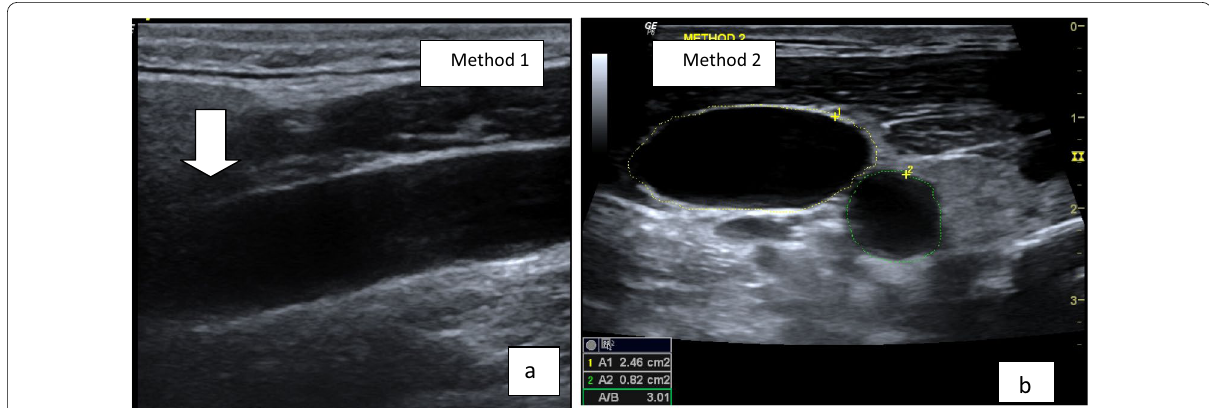
Fig. 6 Ultrasound images for a 40 years old female patient ( a ) a longitudinal ultrasound image where the IJV was distended although its neck course and no collapsing point was detected till the level of the skull base (vertical white arrow) (method 1) ( b ) transverse ultrasound image for the cross‑sectional areas (marked as dotted yellow lines by manual tracers) of the IJV ( (method 2). The Invasive CVP measurement (by the catheter) was 21